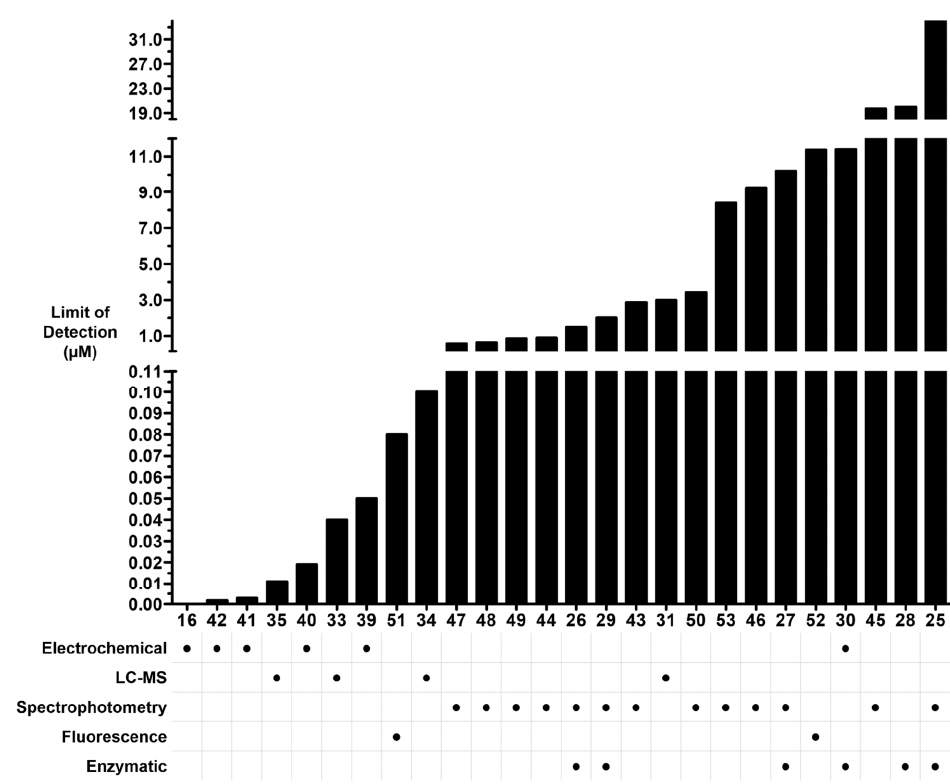
Figure 6. Limit of detection (LOD) of oxalate vs. mode of detection. Bars are broken for visibility of lower LOD. Numbers on horizontal axis represent reference numbers. LOD for reference 16 was reported at 0.2 mg/100 g in food, but linearity in final solution started at 5.68 × 10 − 6 .